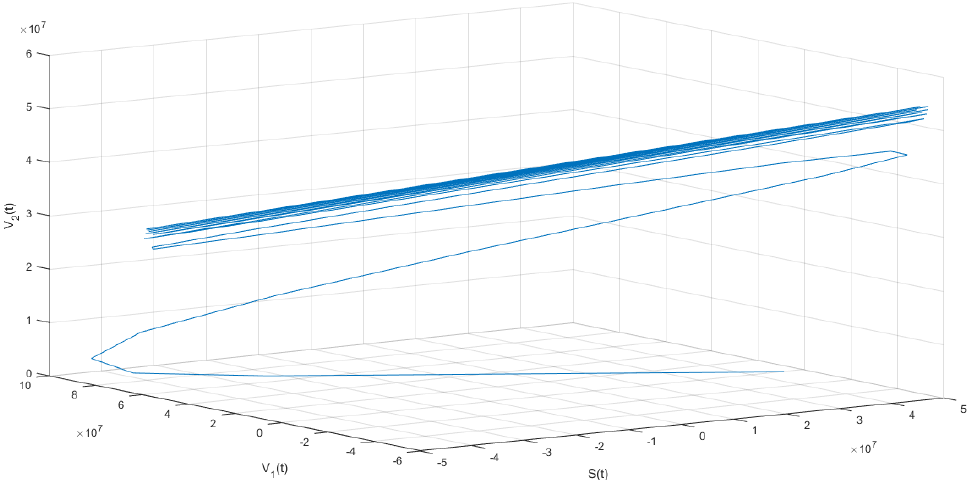
Figure 6. Numerical simulation of system (1) with the following values for the parameters: β I = 0.02 × 10 − 5 , β A = 0.02 × 10 − 5 , ν 1 = 1.5, ν 2 = 2.1, τ = 3.1 ≈ τ ∗